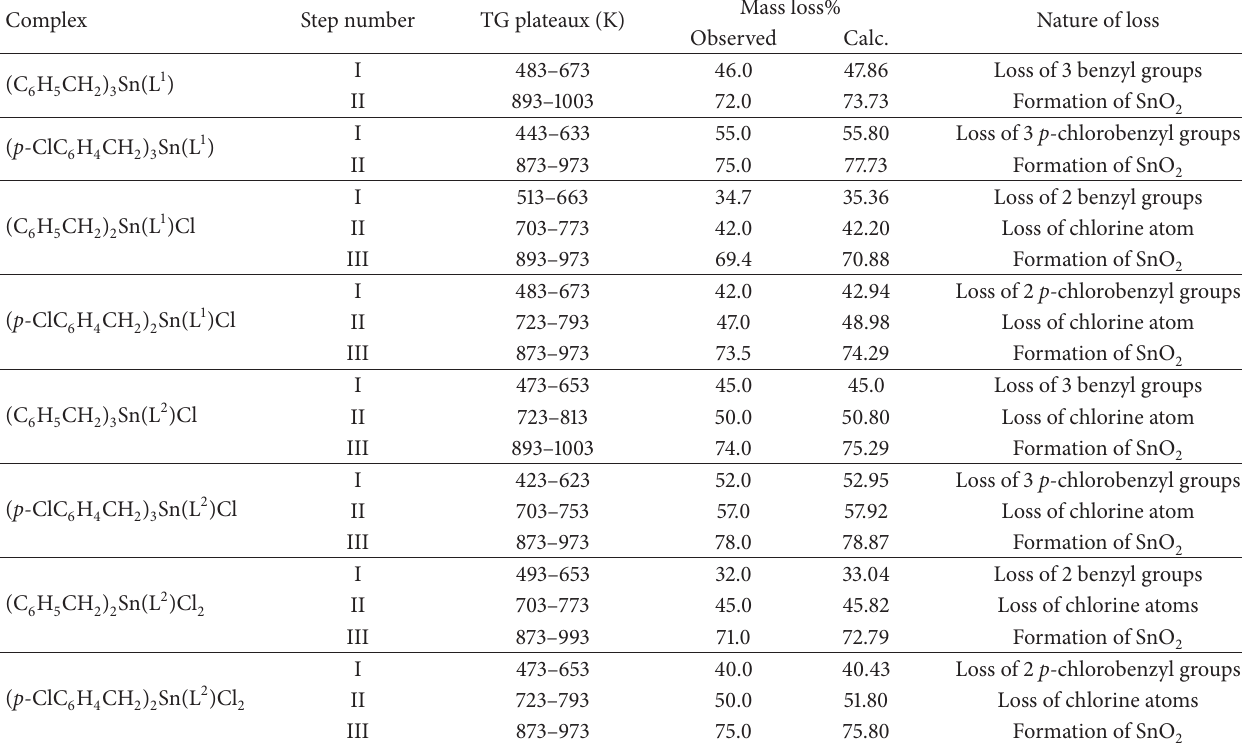
Table 4: Phenomenological data for the thermal decomposition of the complexes. Complex Step